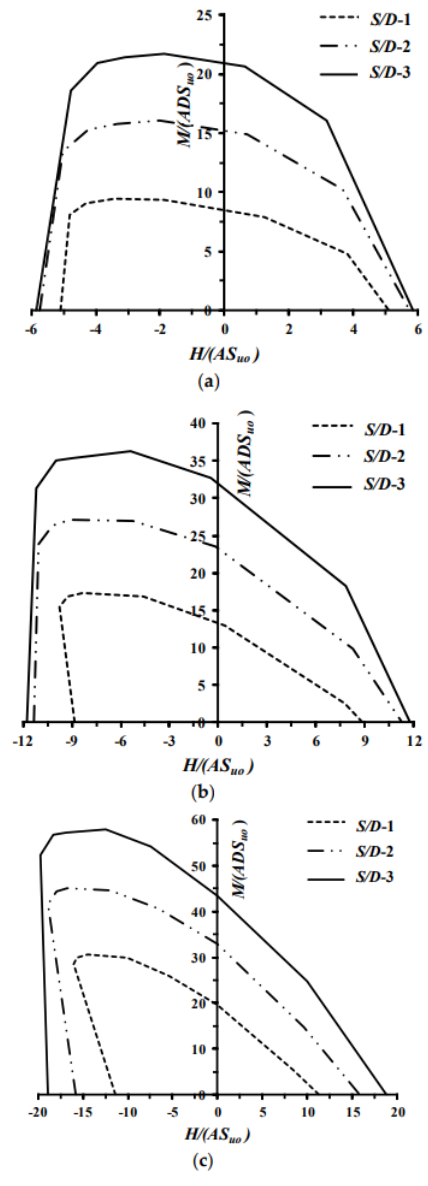
Figure 16. Dimensionless H-M capacity envelopes under different L / D and S / D ratios: ( a ) L / D = 1, ( b ) L / D = 1.5 and ( c ) L / D = 2.